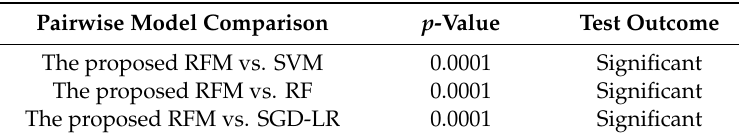
Table 4. The Wilcoxon signed-rank test results. Pairwise Model